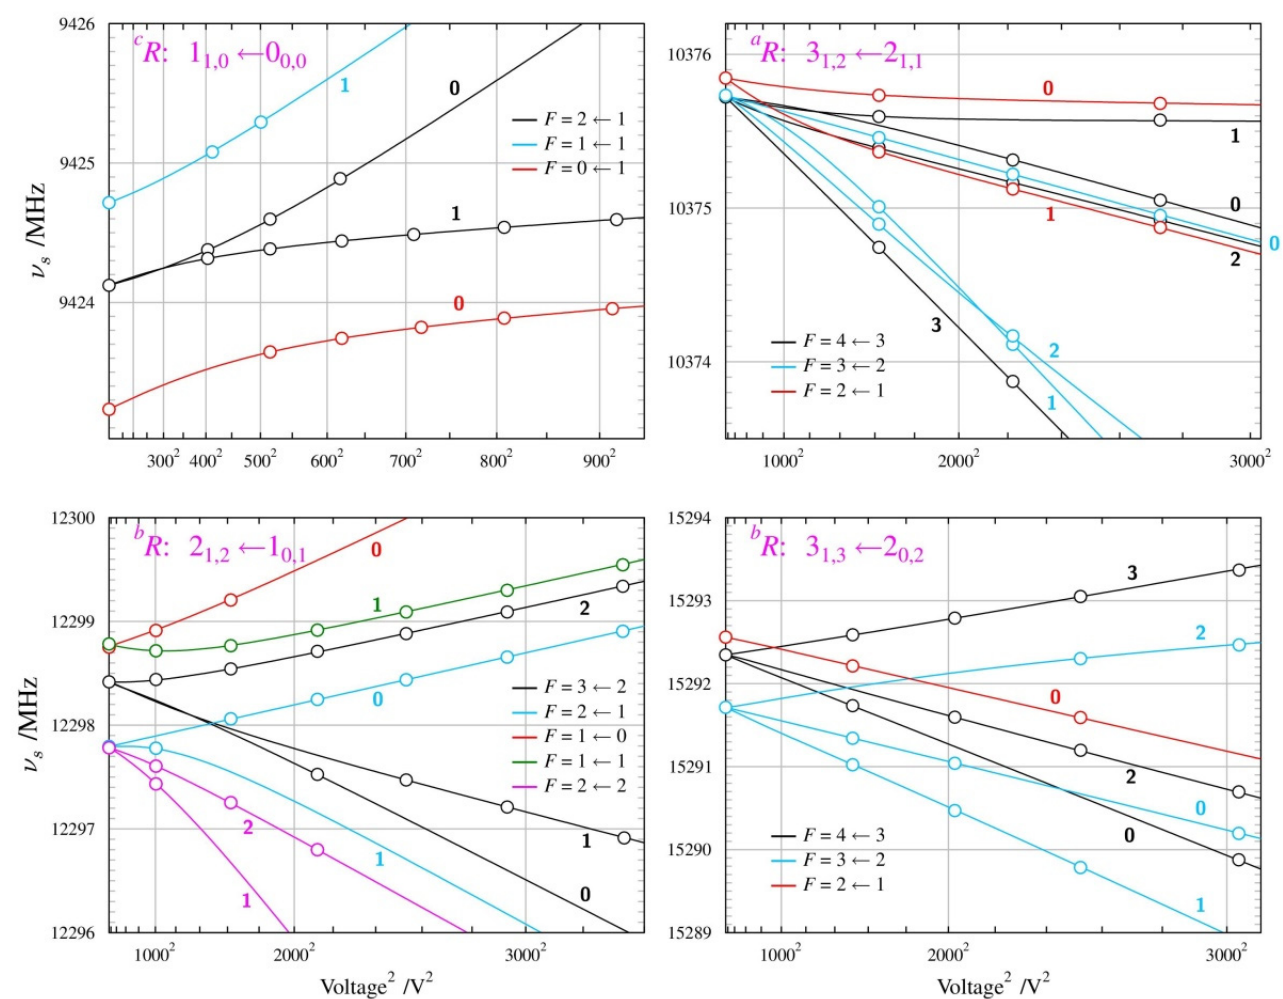
Figure 9. Summary of Stark measurements for the less stable GA conformer of n -butyl cyanide (see the caption of Figure 8 for details). In this case, it was possible to measure Stark components of rotational transitions allowed by all three non-zero dipole moment components, which are the only parameters of fit reproducing the complex behaviour in the four panels. Table 4. Electric dipole moments of the AA and GA conformers of n -butyl cyanide. n -Butyl Cyanide